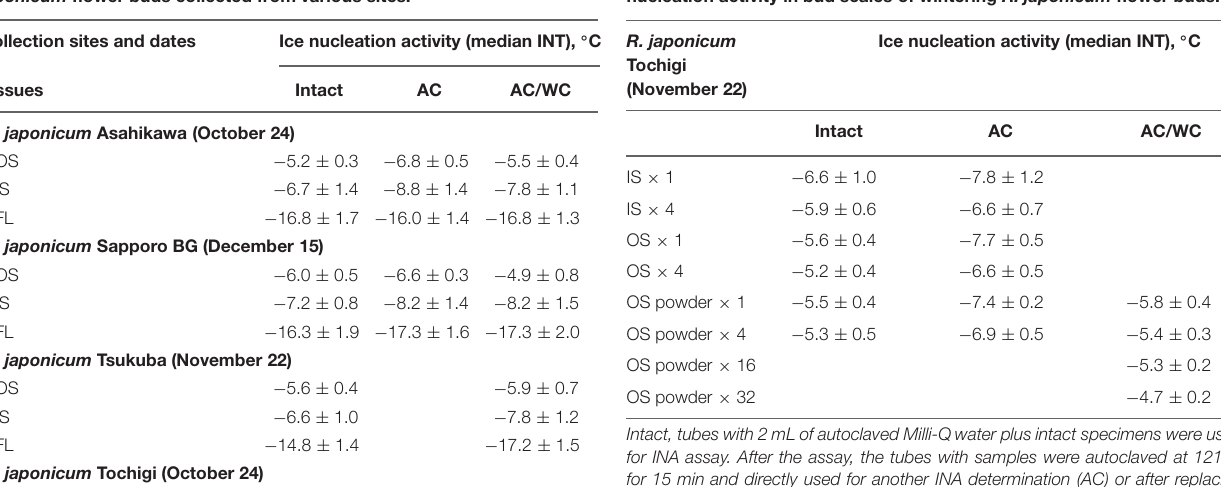
TABLE 2 | Effect of sample amount, grinding and autoclaving on the ice nucleation activity in bud scales of wintering R. japonicum flower